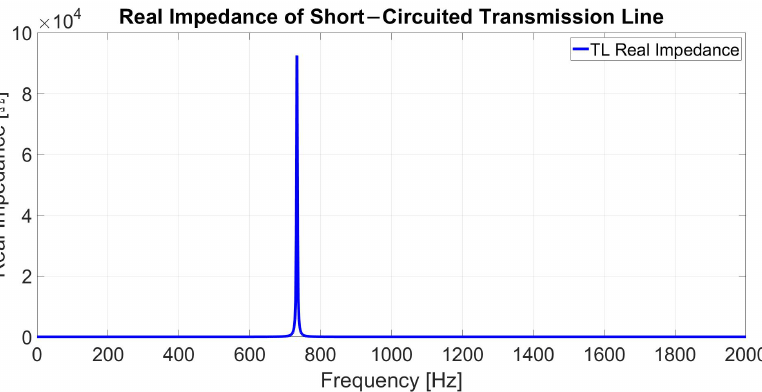
Figure 6. Frequency response measurements of a single phase transmission line real